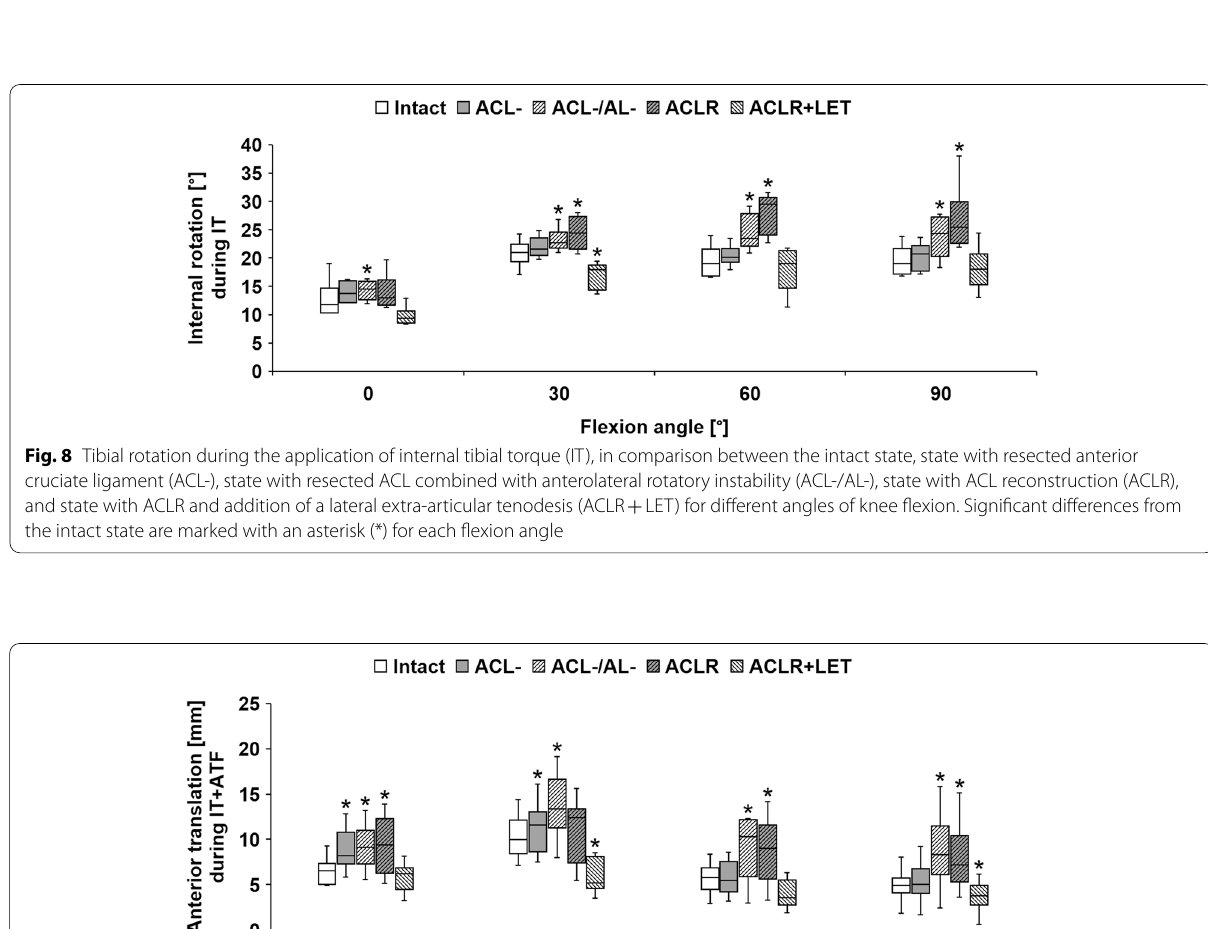
ATF), in comparison + LET) for +